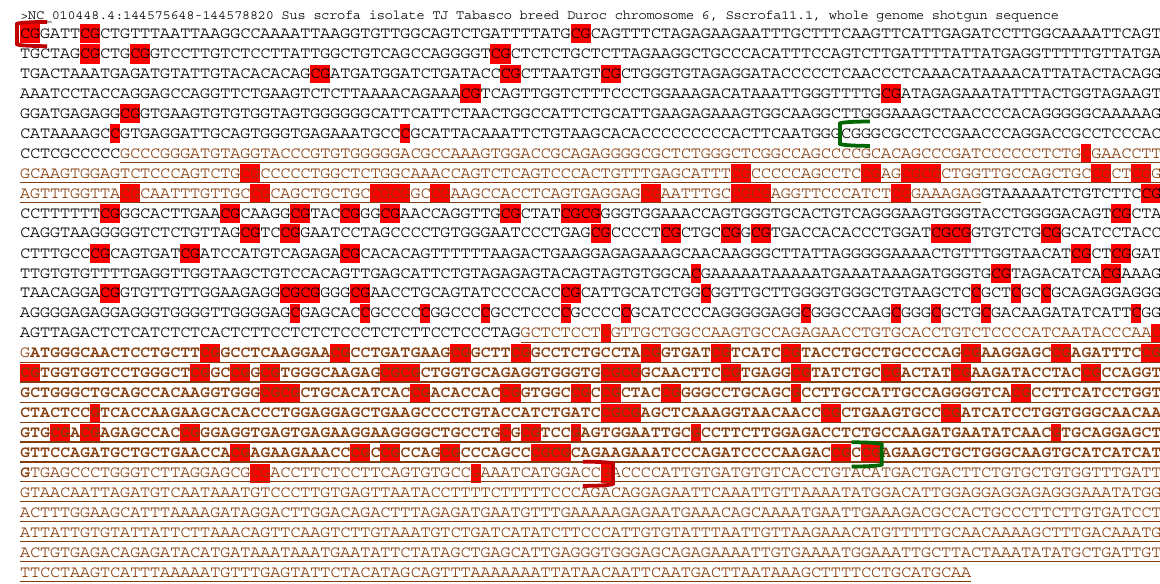
Figure 2. Distribution of differential methylation (i.e., maternal hypermethylation) in the DIRAS3 locus of the porcine parthenogenetic (PA) embryos compared to the control (CN) embryos. The nucleotide sequence of the genomic DNA covers a promoter (black), exon 1 (brown, underlined), intron (black), and exon 2 (brown, underlined) of the porcine DIRAS3 gene from the beginning to the end. Brown bold faces in exon 2 indicate a translated region. This partial genomic DNA sequence in chromosome 6 (chr6 or NC_010448.4:144575648-144578820) of the reference pig genome (Sscrofa11.1 or susScr11) was retrieved from the NCBI Nucleotide database (https://www.ncbi.nlm.nih.gov/nuccore, accessed 15 January 2021). The start and end of the CpG island (chr6:144576300-144578127) and DMR (displayed in Figure 1) are denoted with green and red brackets, respectively. Differentially methylated CpGs (or Cs) between PA and CN (i.e., hypermethylated in PA) are highlighted with red. Highlighted Gs indicate methylated Cs on the minus strand (coding strand). To call a DMR with a threshold, metilene was used, as mentioned in the Materials and Methods.